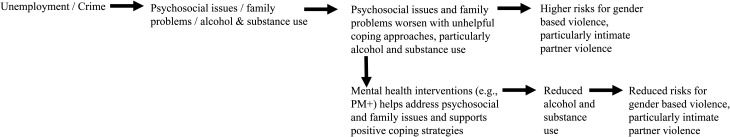
Theoretical progression of common problems faced by men in Muitini and Waithaka, Kenya, leading to risk for perpetration of GBV, and potential for reducing risk by supporting men's mental health.